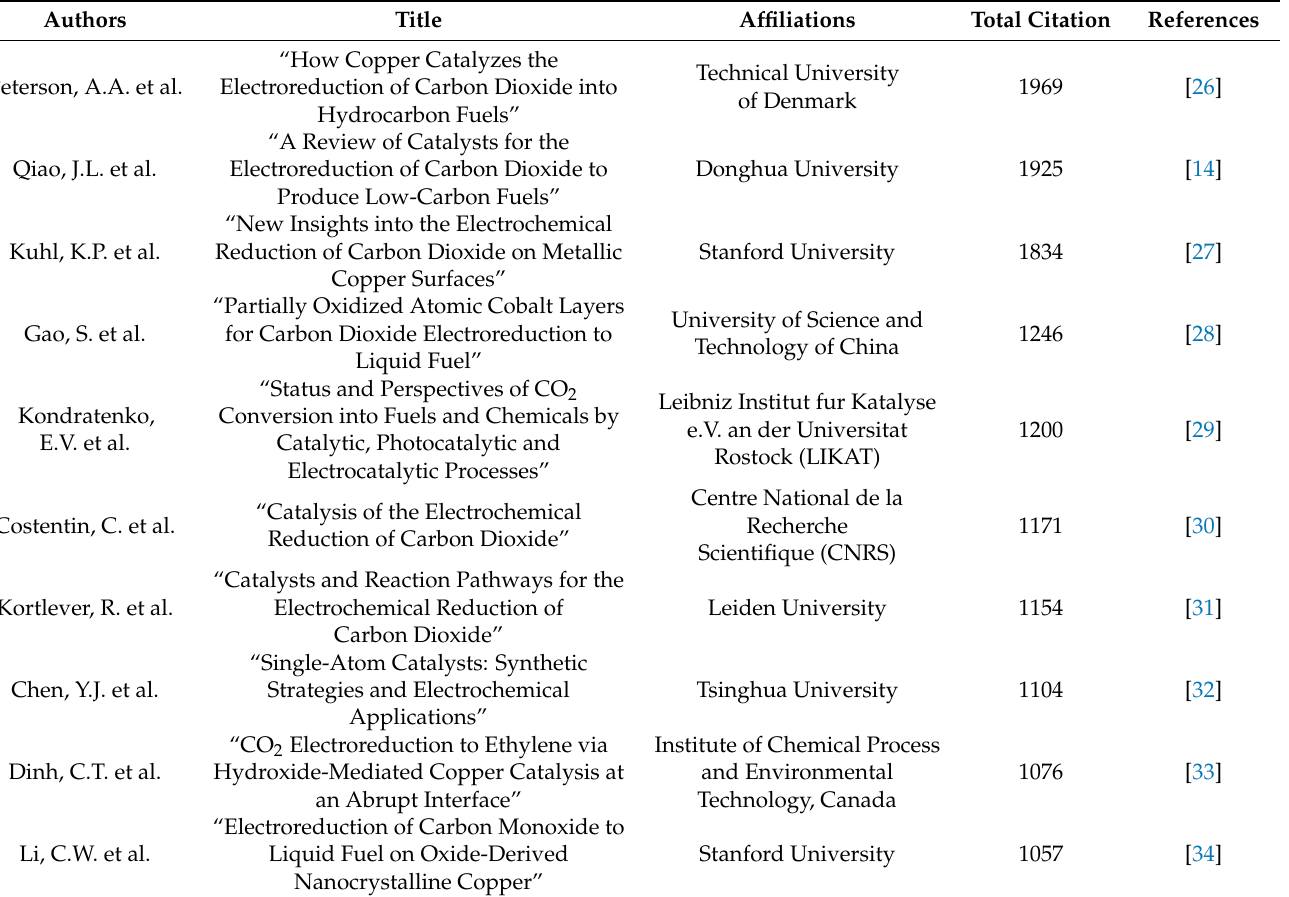
Table 4. Top ten most cited